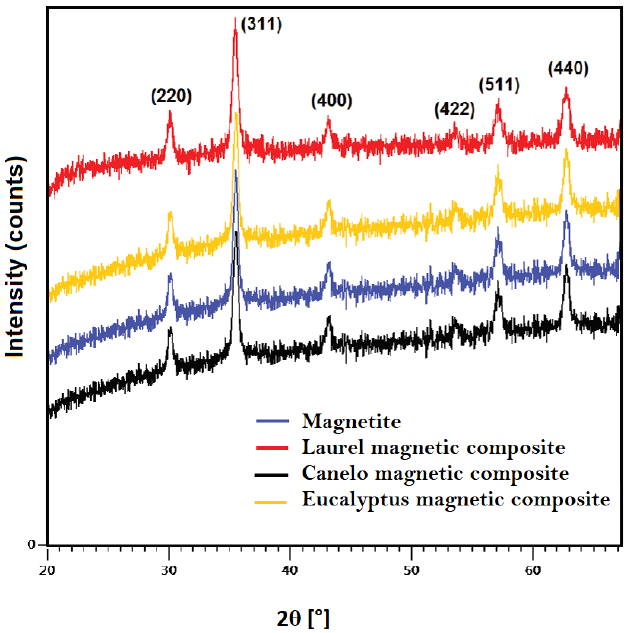
Figure 4. X-ray diffraction pattern of magnetite nanoparticles and magnetic composites.